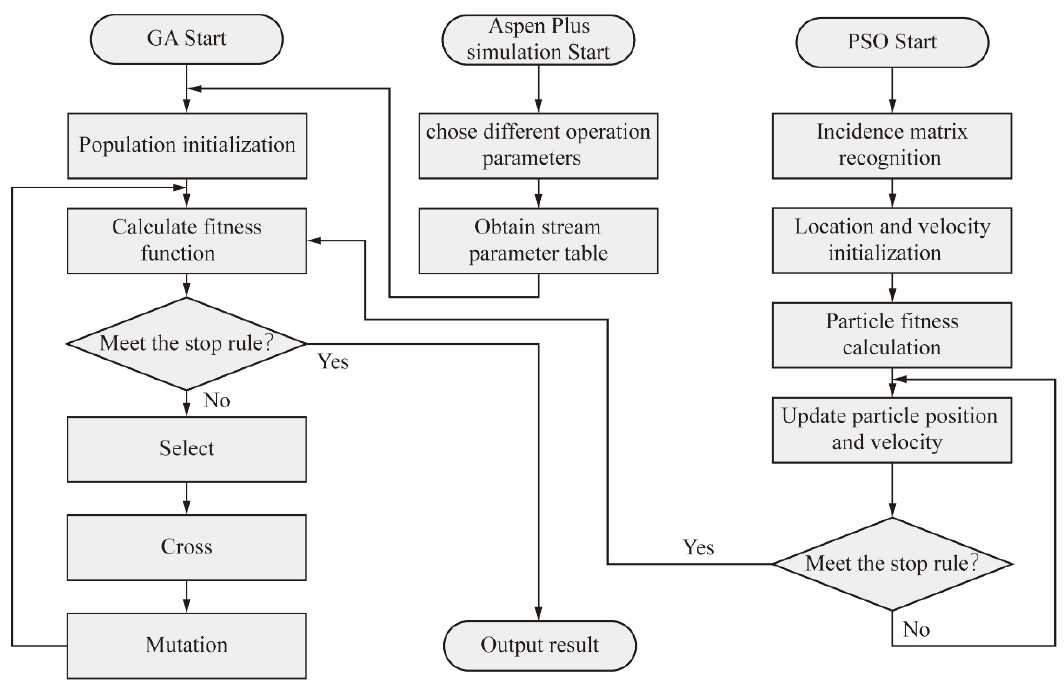
Figure 3. Heat exchange network design procedure steps.